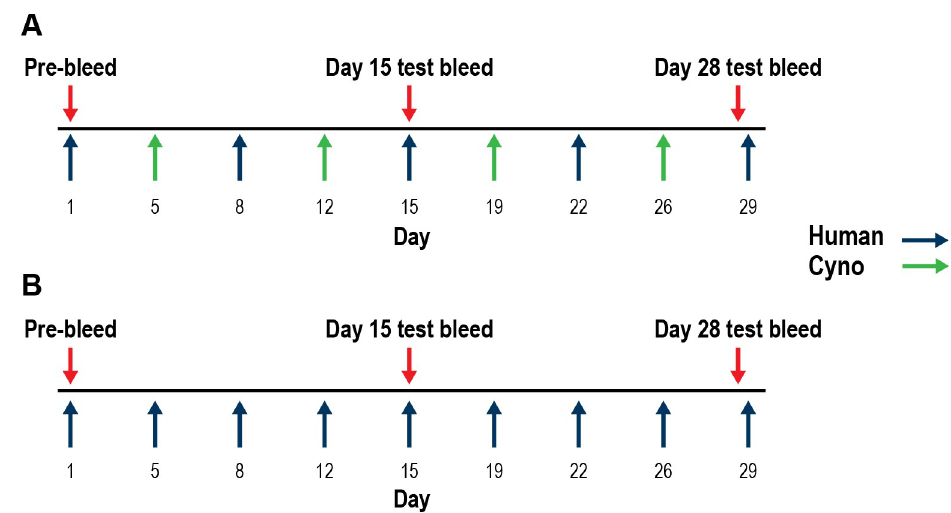
Fig 1. Alternating dual-antigen vs single-antigen immunization strategy for inducing a potent neutralizing antibody response in mice. (A) Alternating immunization of mice with human IL-21–BSA and cyno IL-21–BSA in alum adjuvant via the intraperitoneal and metatarsal routes. (B) Immunization of mice with human IL-21–BSA in alum adjuvant via the intraperitoneal and metatarsal routes.